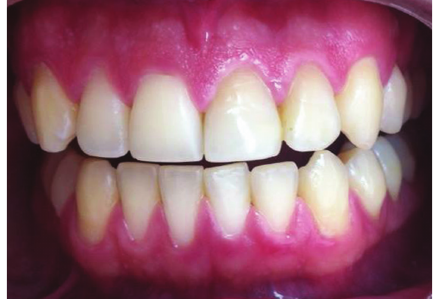
Figure 8: Clinical aspect showing the normal function of teeth 21 and 22 (October